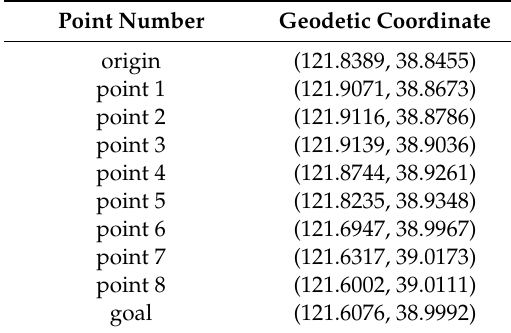
Figure 24. Static global path planning. Table 1. Geodetic coordinates of key navigation points in the global static planning path.